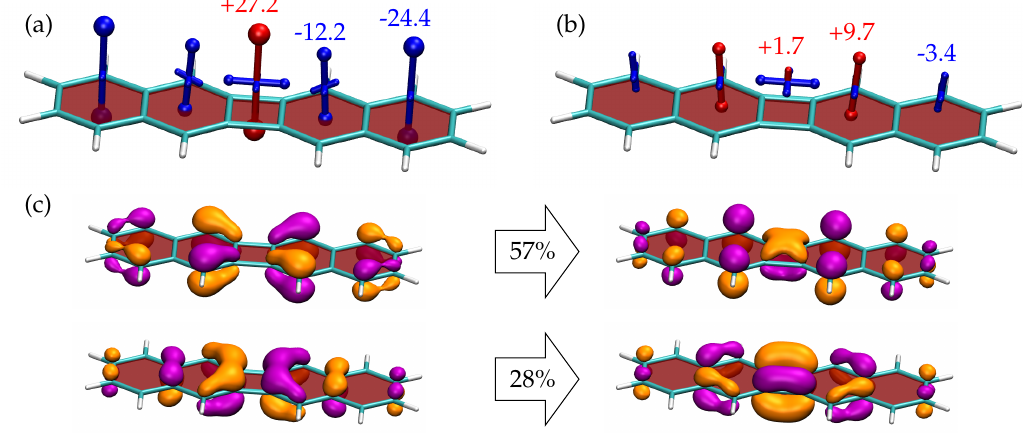
Figure 6. Visualisation of chemical shielding tensors (VIST) for ( a ) the S 0 and ( b ) the T 1 states of 3 computed 1 Å above the molecular plane. The two dominant pairs of natural transition orbitals (isovalue 0.05 a.u.) for the S 0 → T 1 transition are shown in ( c